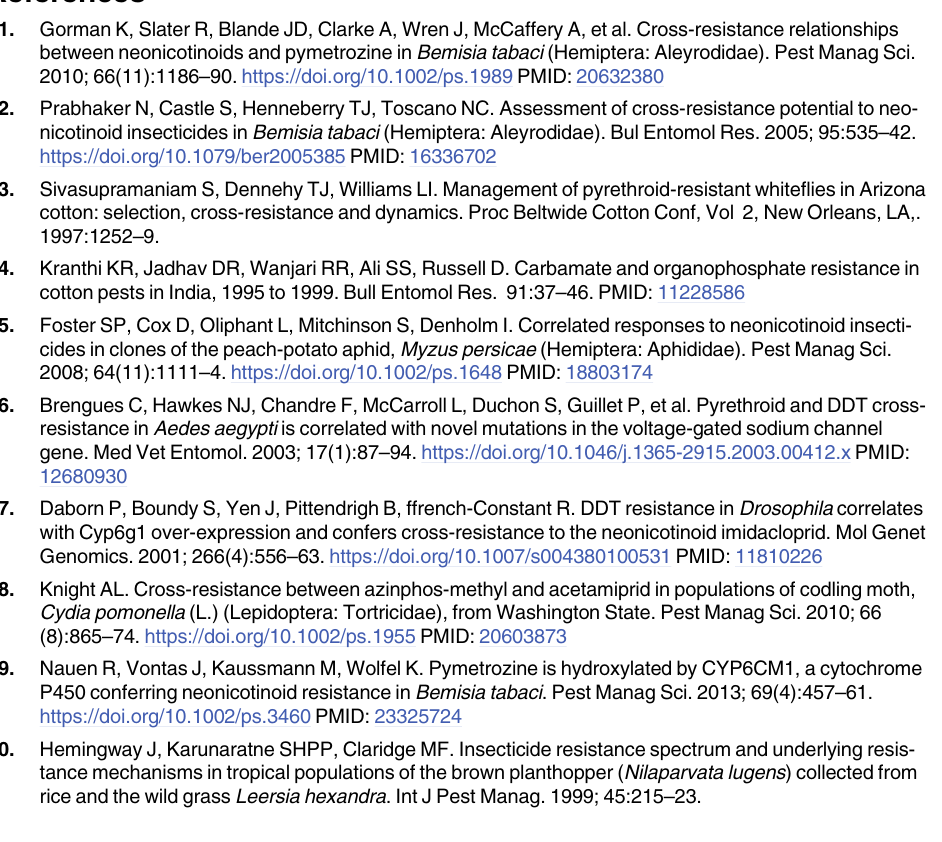
S9 Table. Sequence of oligonucleotide primers used in this